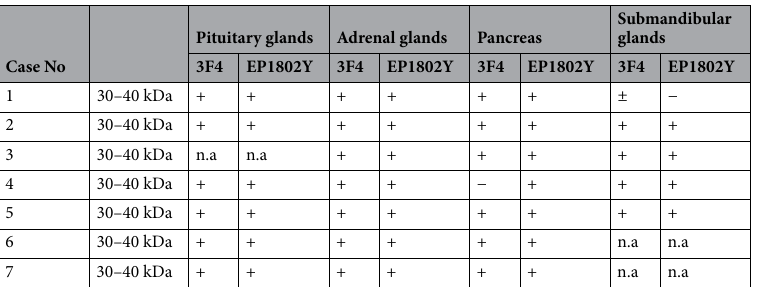
Table 2. The molecular characteristics of prion proteins by western blot from FFPE samples with 3F4 and EP1802Y antibodies. Scale: –, negative; ± , weakly positive; + , positive; n. a., not available.